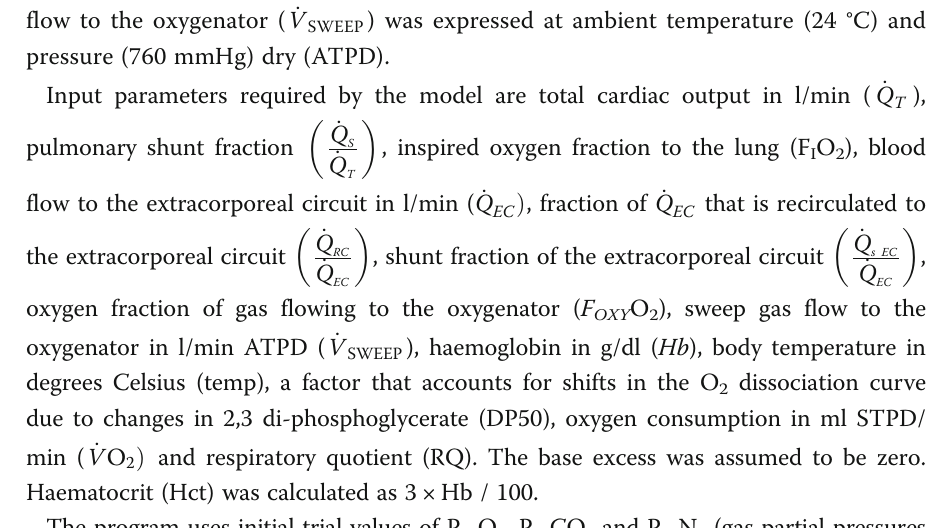
Fig. 1 Outline of the ECMO model. Blood flow shown in blue. _ Q T is cardiac output, _ Q L is blood flow to lung compartment, _ Q S is pulmonary shunt blood flow, _ Q EC is blood flow to the extracorporeal blood circuit, _ Q oxy is blood flow to the ideal oxygenator compartment that participates in gas exchange, while blood flow that does not participate in gas exchange. _ Q EC includes both recirculated blood flow ( _ Q RC Þ and part of the “ mixed venous ” blood flow from the tissues. Gas flows shown in green. _ V A is alveolar ventilation, _ V D is dead space ventilation, _ V E is expired minute ventilation, _ V SWEEP is sweep gas flow to the oxygenator, oxygenator and lung are modelled as ideal lung compartments. Tissues consume O 2 and produce CO 2 . “ Arterial ” blood perfuses the tissues, and “ Mixed Venous ” blood drains from the tissues. “ Pulmonary Arterial ” blood is a mixture of blood that has passed through the extracorporeal circuit, and blood that has